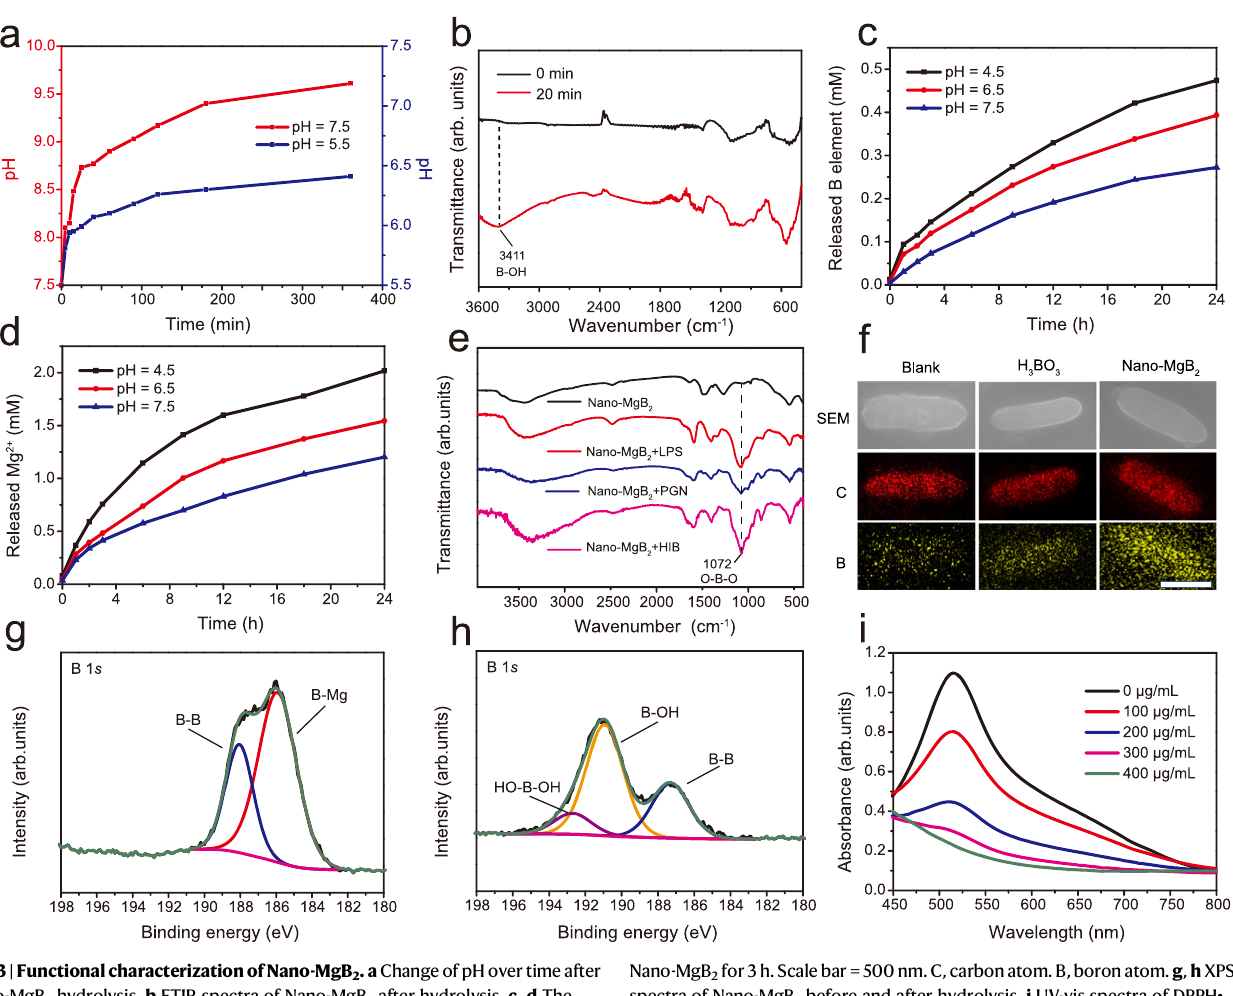
Nano-MgB 2 for3h.Scalebar=500nm.C,carbonatom.B,boronatom. g , h XPS fi ne spectra of Nano-MgB 2 before and after hydrolysis. i UV-vis spectra of DPPH (cid:129) scavenging ability with different concentrations of Nano-MgB 2 . Data are repre- sentative of at least three independent experiments with similar results. Source data are provided as a Source data fi